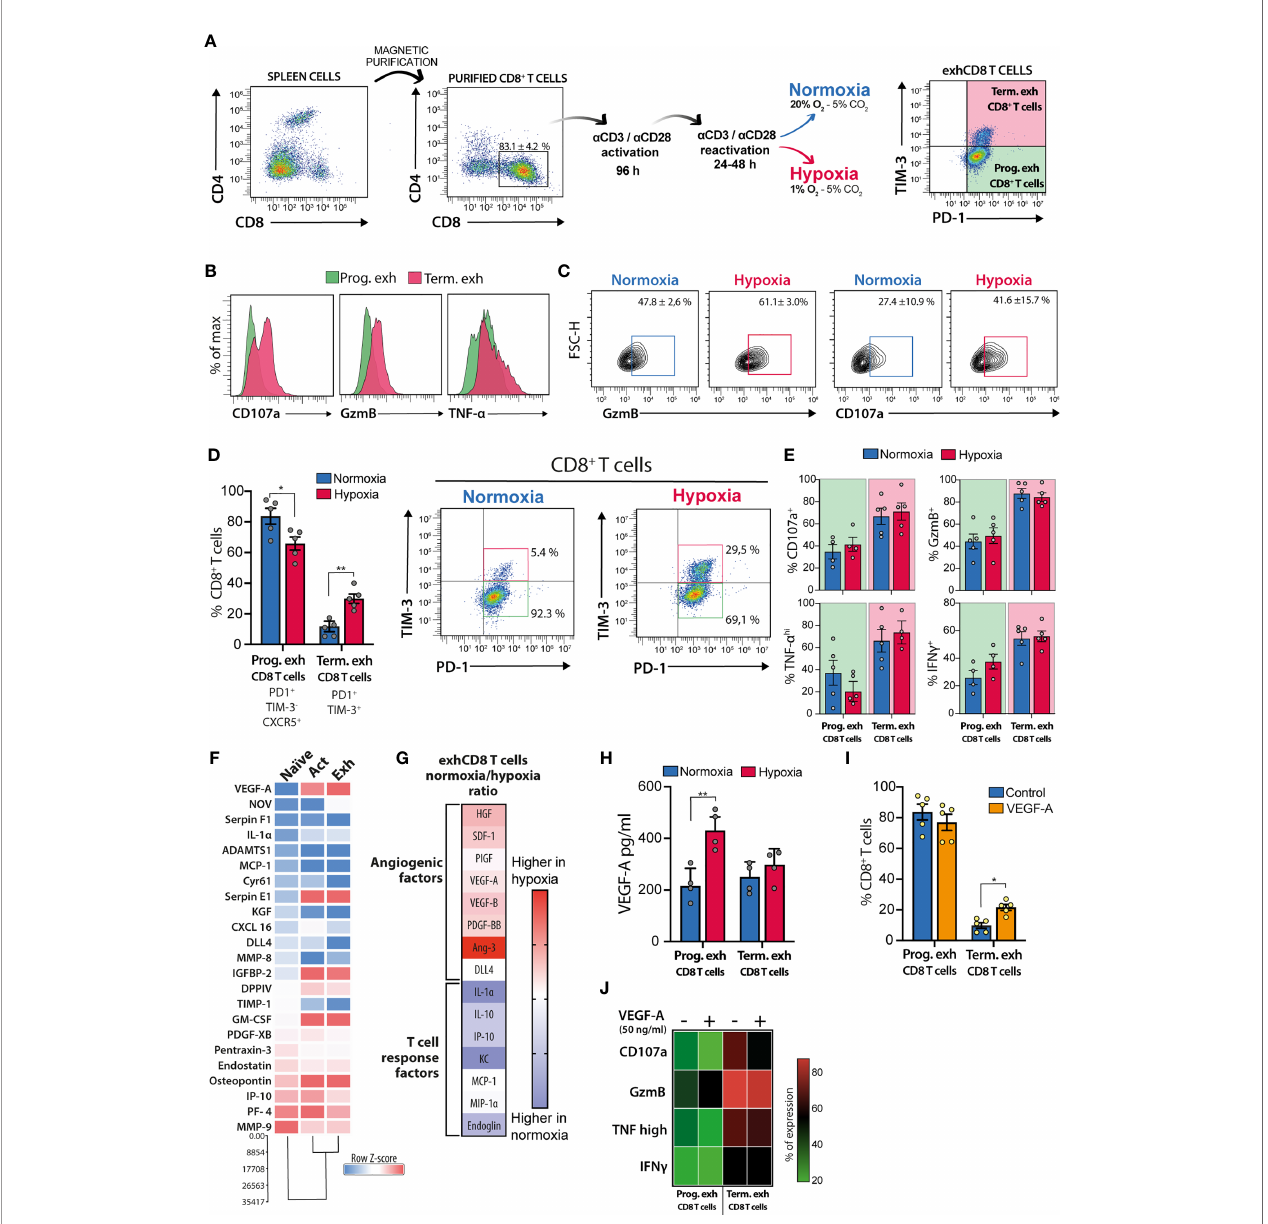
FIGURE 2 | Hypoxia and VEGF-A promote differentiation of terminally exhCD8 T cells. (A) Schematic representation of work fl ow and gating strategy for in vitro differentiation of exhCD8 T cells. (B) Representative histograms showing intracellular staining of CD107a, Granzyme-B (GzmB), and TNF- a in progenitor (green) or terminally (pink) exhCD8 T cells. (C) Representative contour plots showing GzmB and CD107a expression in CD8 + PD-1 + T cells after 24 h exposure to hypoxia (1% O 2 ) or normoxia (20% O 2 ). (D) Differentiation of PD-1 + TIM-3 - CXCR5 + progenitor exhCD8 T cells and PD-1 + TIM-3 + terminally exhCD8 T cells under normoxic (blue bars) or hypoxic (red bars) conditions. Left, percentage of each subpopulation. Right, representative density plots showing the subpopulations. Data are the mean ± SEM of fi ve independent experiments. (E) Determination of cytokine expression by intracellular fl ow cytometry in different exhCD8 T cell subpopulations under normoxic or hypoxic conditions. Data are the mean ± SEM of 4 independent experiments. (F) Heat map representing normalized row Z-score of semiquantitative cytokine array analysis of angiogenic factors secreted by CD8 + T cells during the differentiation process. Data shows densitometric determinations and cluster analysis of pooled supernatants from fi ve independent experiments. (G) Representation of the ratio of cytokines secreted by exhCD8 T cells under normoxic or hypoxic conditions. Heat maps represent the ratio of normalized densitometric data for each cytokine in normoxia versus hypoxia. (H) VEGF secretion by PD-1 + TIM- 3 - CXCR5 + progenitor exhCD8 T cells and PD-1 + TIM-3 + terminally exhCD8 T cells under normoxic (blue bars) or hypoxic (red bars) conditions. Data are the mean ± SEM of four independent experiments. (I) Differentiation of PD-1 + TIM-3 - CXCR5 + progenitor exhCD8 T cells and PD-1 + TIM-3 + terminally exhCD8 T cells in the presence (orange bars) or in the absence (blue bars) of VEGF-A (50 ng/ml). Data are the mean ± SEM of fi ve independent experiments. (J) Heat map representation of intracellular cytokines determined by fl ow cytometry in different exhCD8 T cells subpopulations in the presence or the absence of VEGF-A (50 ng/ml). Each row represents the mean ± SEM of the percentage of cells expressing each cytokine in four independent experiments. *p < 0.05, **p <